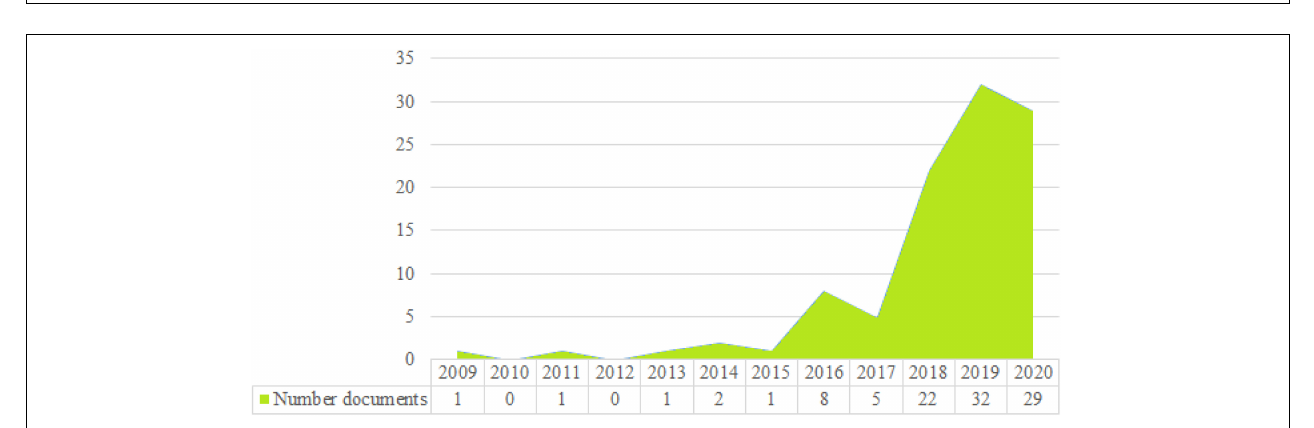
FIGURE 1 | Evolution view and period view. Source: Cobo et al. (2012).